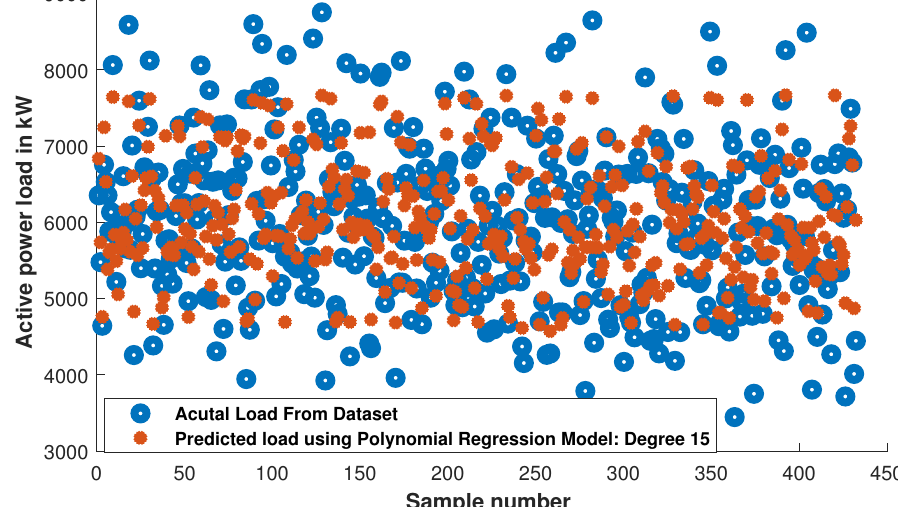
Figure 20. PR: comparison of actual load and predicted load with trained PR